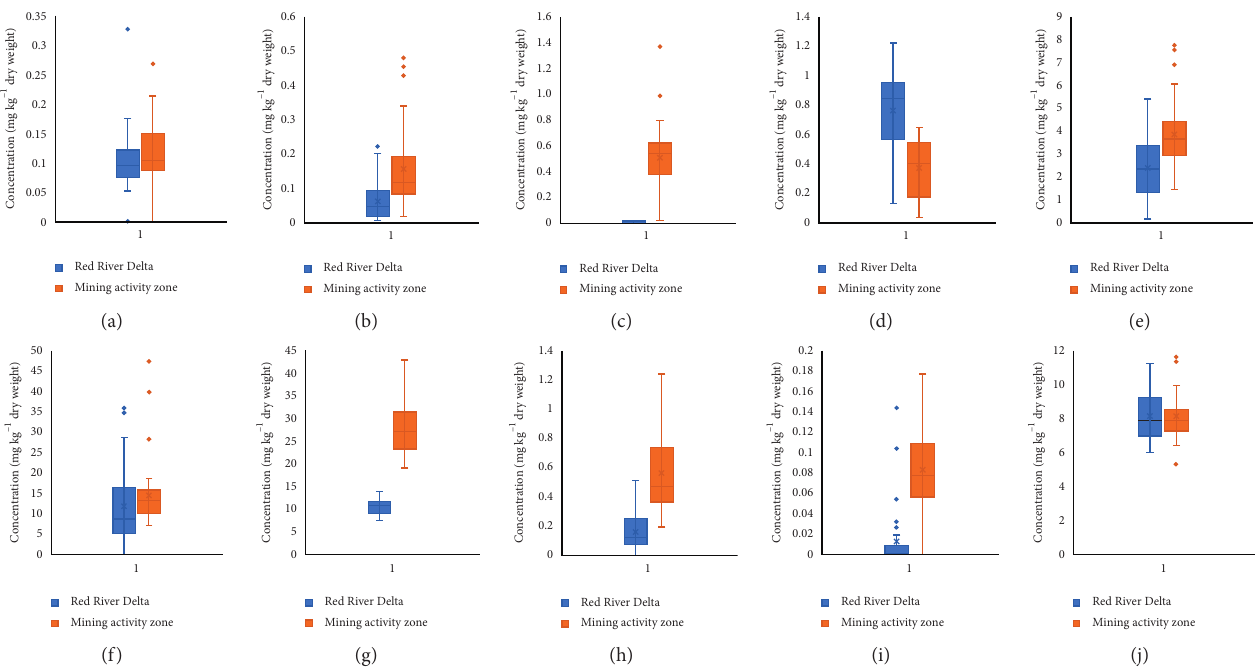
Figure 2: The whisker and box diagram of the heavy metals and arsenic in rice in both sampling areas. (a) As. (b) Cd. (c) Co. (d) Cr. (e) Cu. (f) Fe. (g) Mn. (h) Ni. (i) Pb. (j)